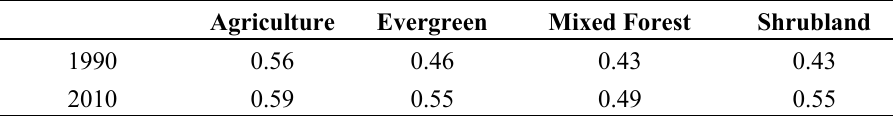
Table 4. Moran’ I for LCLU categories in 1990 and